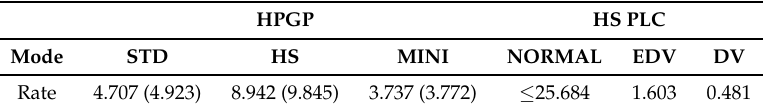
Table 4. Transmission rate for HPGP and HS PLC